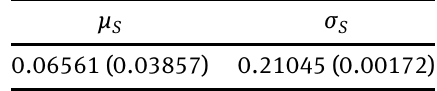
Table 1: Parameters of the GBM obtained by the MLE method with the corresponding standard errors between